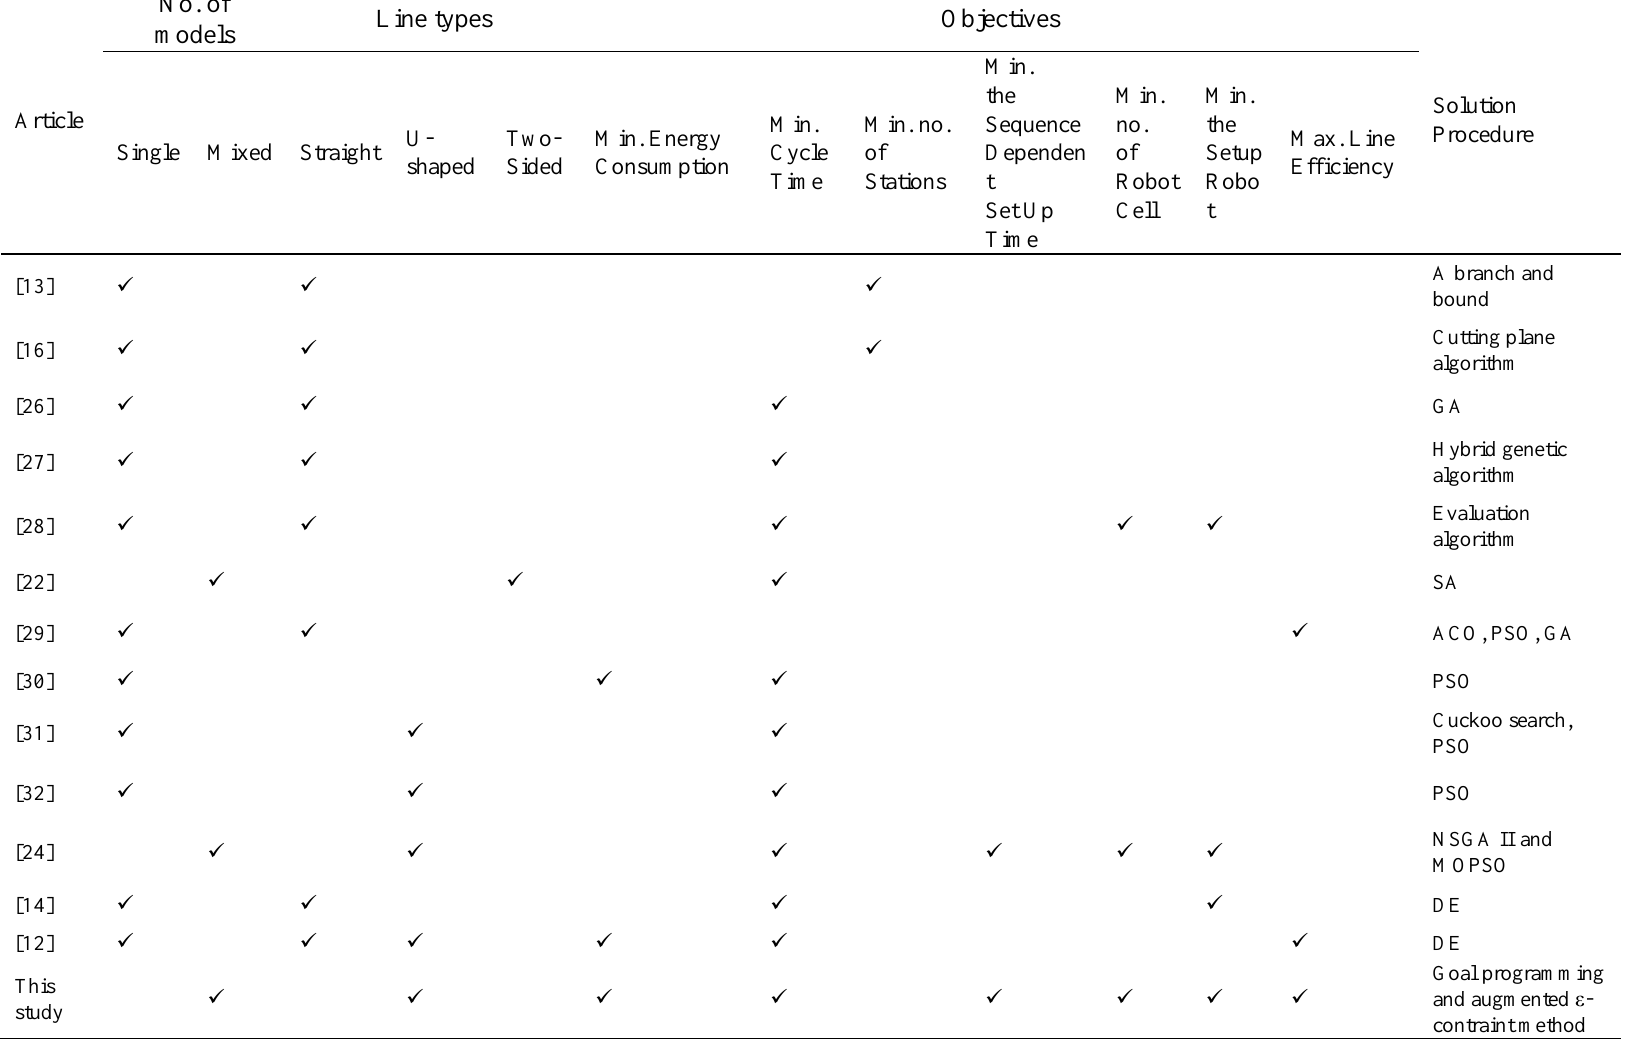
Table 1. Comparison table of the literature on the robotic assembly line balancing